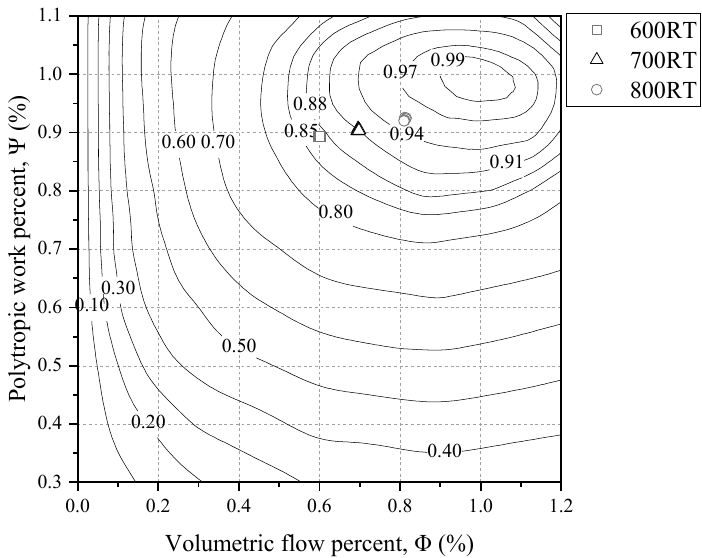
Figure 10. Compressor efficiency factor map.